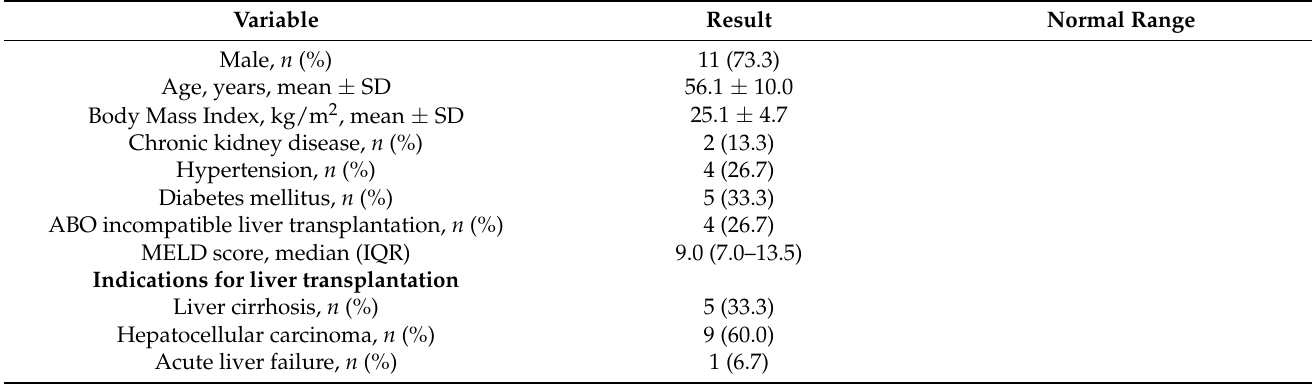
Table 1. Preoperative